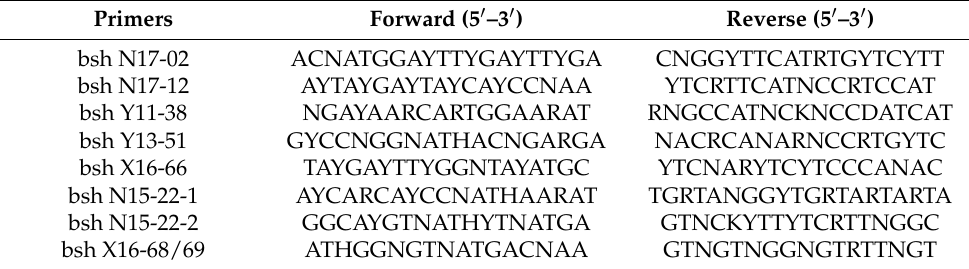
Table 1. Primers used to screen bsh